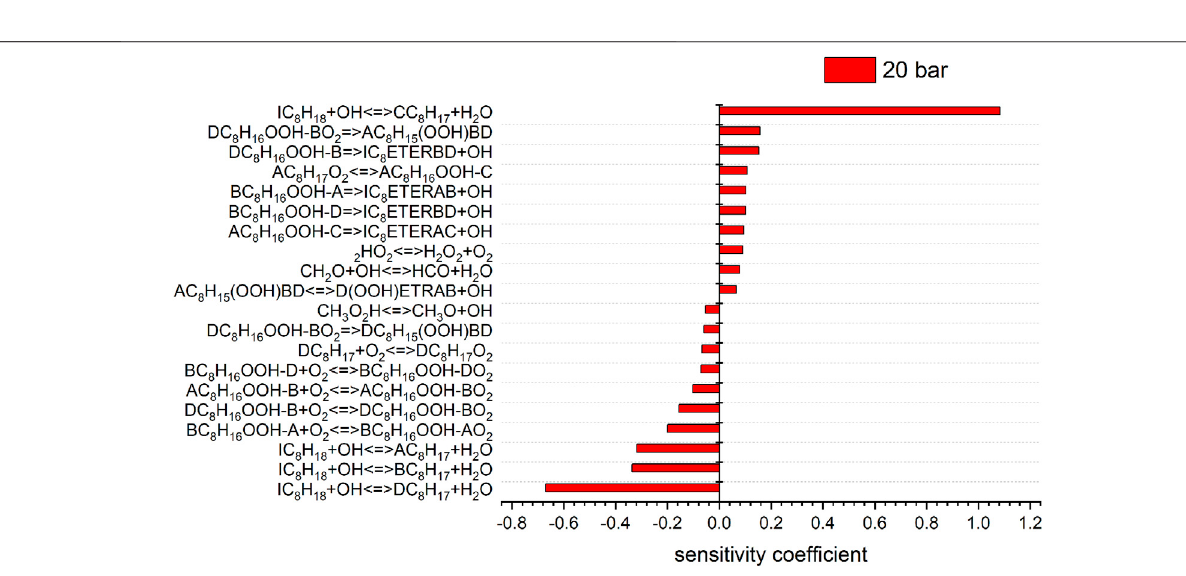
Frontiers in Energy Research |